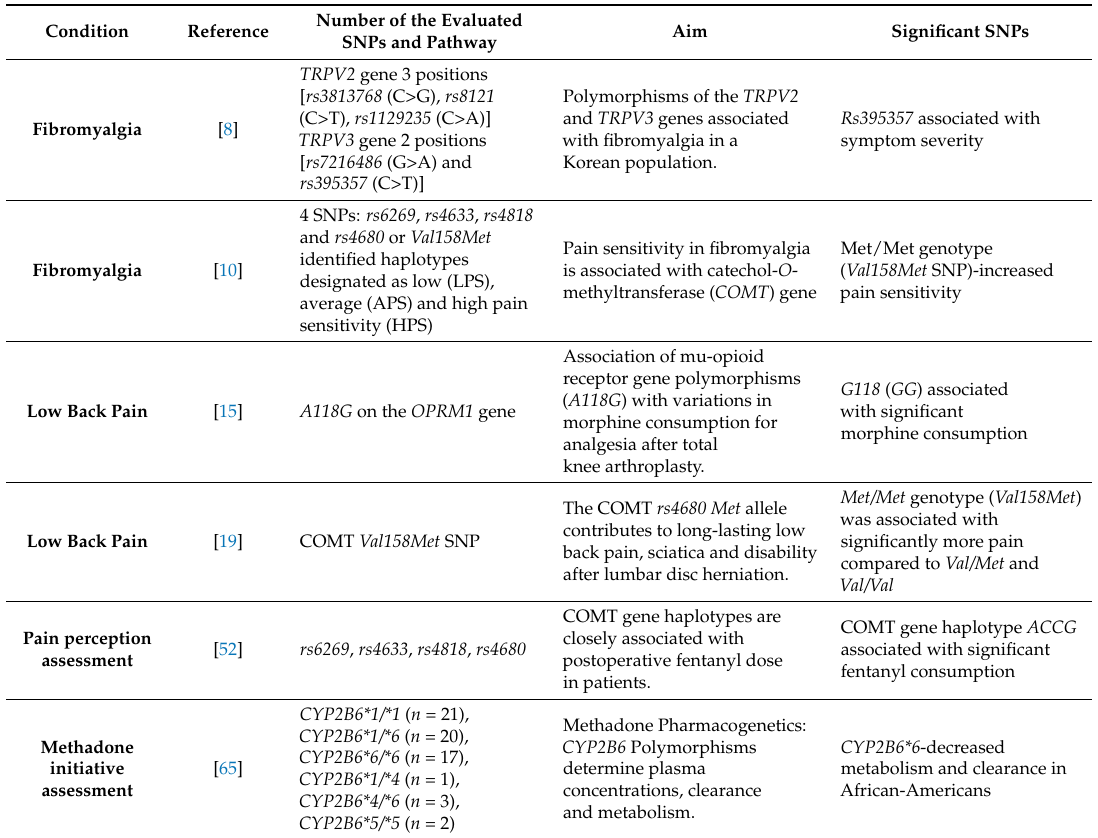
Table 2. Summarizing the main features of the studies that analyzed the role of different SNPs in chronic pain and their impacts in clinical